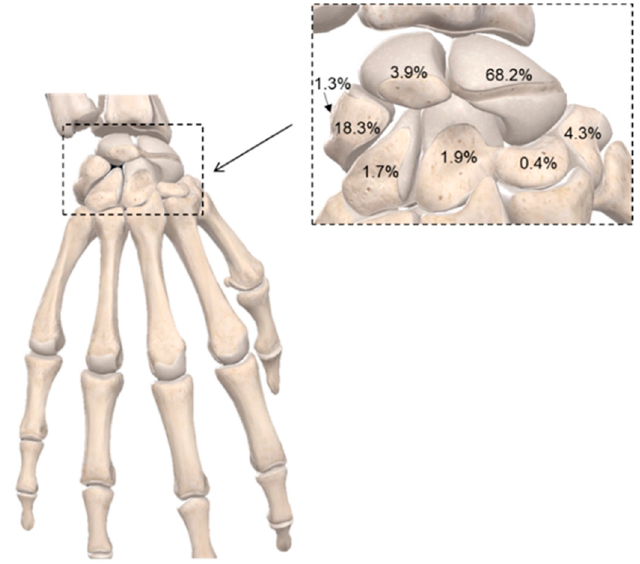
Figure 3. Percentage of fracture incidences per carpal bone.